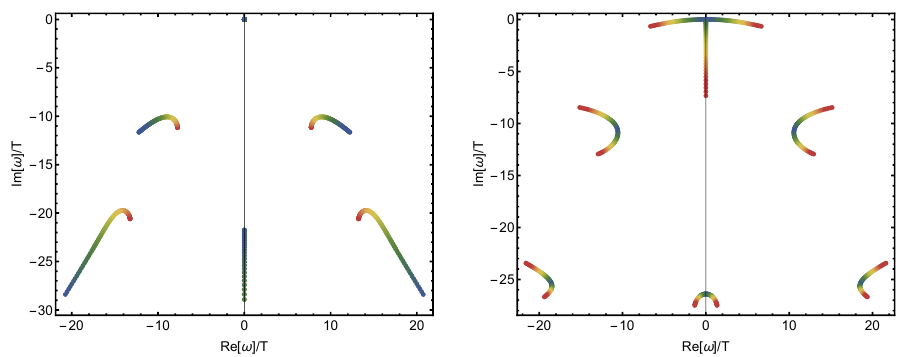
Figure 12 . Spectrum of higher QNMs for the potential V ( X ) = X 3 . Left: the QNM spectrum for vanishing momentum as a function of the dimensionless (inverse) temperature m=T 2 [0 ; 6 : 5] : Blue dots denote low temperatures while red dots refer to high temperatures. Right: the QNM spectrum for (cid:12)xed temperature m=T = 0 : 179 as a function of the dimensionless momentum k=T 2